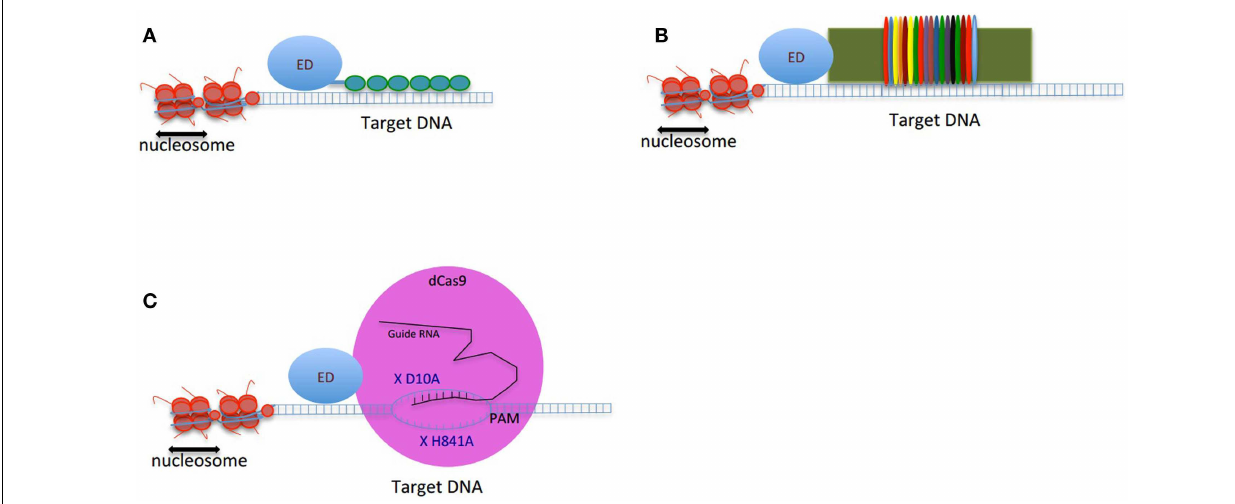
FIGURE 1 | Schematic figure of genome-editing tools composed of an effector domain (ED) fused to a DNA-binding domain: (A) ZFP, (B)TALEs, and (C) CRISPRs .The double-strand DNA is shown as two parallel blue lines, the vertical small lines connecting the two strands of DNA are representing the hydrogen bonds between nucleotides.The small green circles in (A) are presenting 6-finger ZFP.The colorful thin ovals in